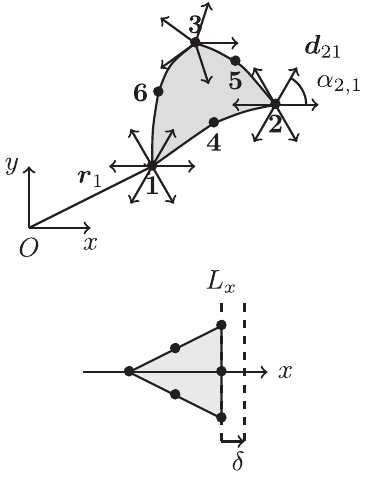
Figure 3. Top: example of a PUFEM triangular element. Plane wave basis are associated with vertices j = 1, 2 and 3 with Q 1 = Q 2 = 6 and Q 3 = 5. The element geometry is described using quadratic shape functions including edge nodes 4, 5 and 6. Bottom: triangular element in the PML region sharing an edge with the outer boundary x = L x .